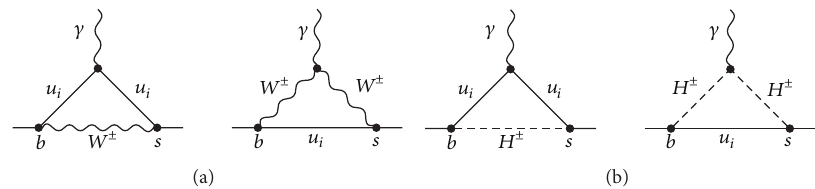
Figure 6: Examples of one-loop 1PI diagrams that contribute to 𝑏 → 𝑠𝛾 in a 2HDM framework, with 𝑊 bosons, charged Higgs, and 4th generation quarks exchanges ( 𝑢 𝑖 = 𝑢,𝑐,𝑡,𝑡 󸀠 ).